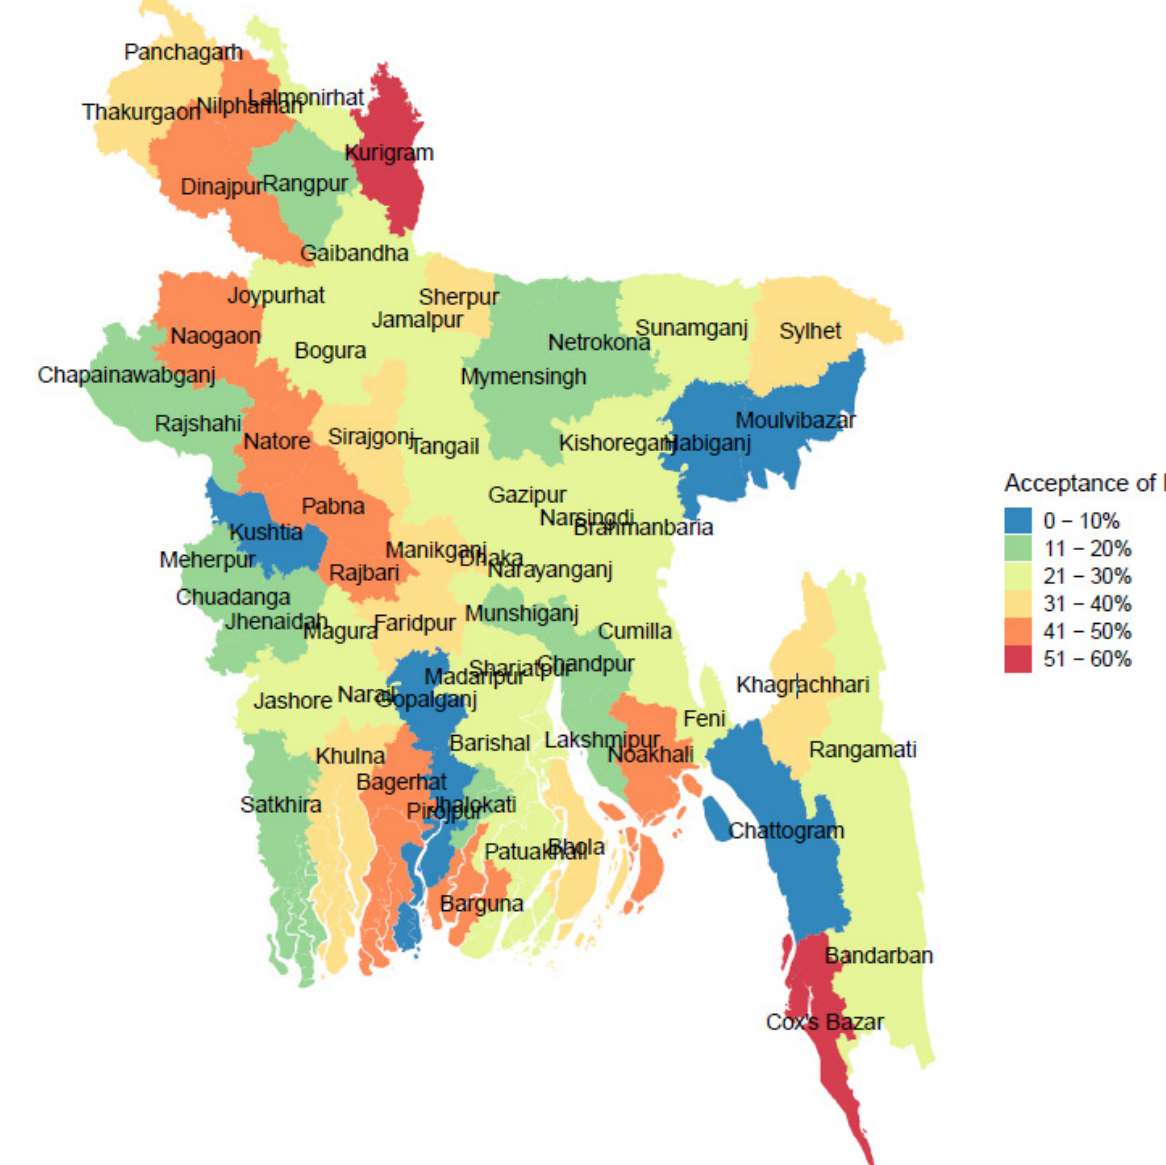
Figure 1. Geospatial distribution of women’s attitude toward acceptance of IPV among 64 districts in Bangladesh.